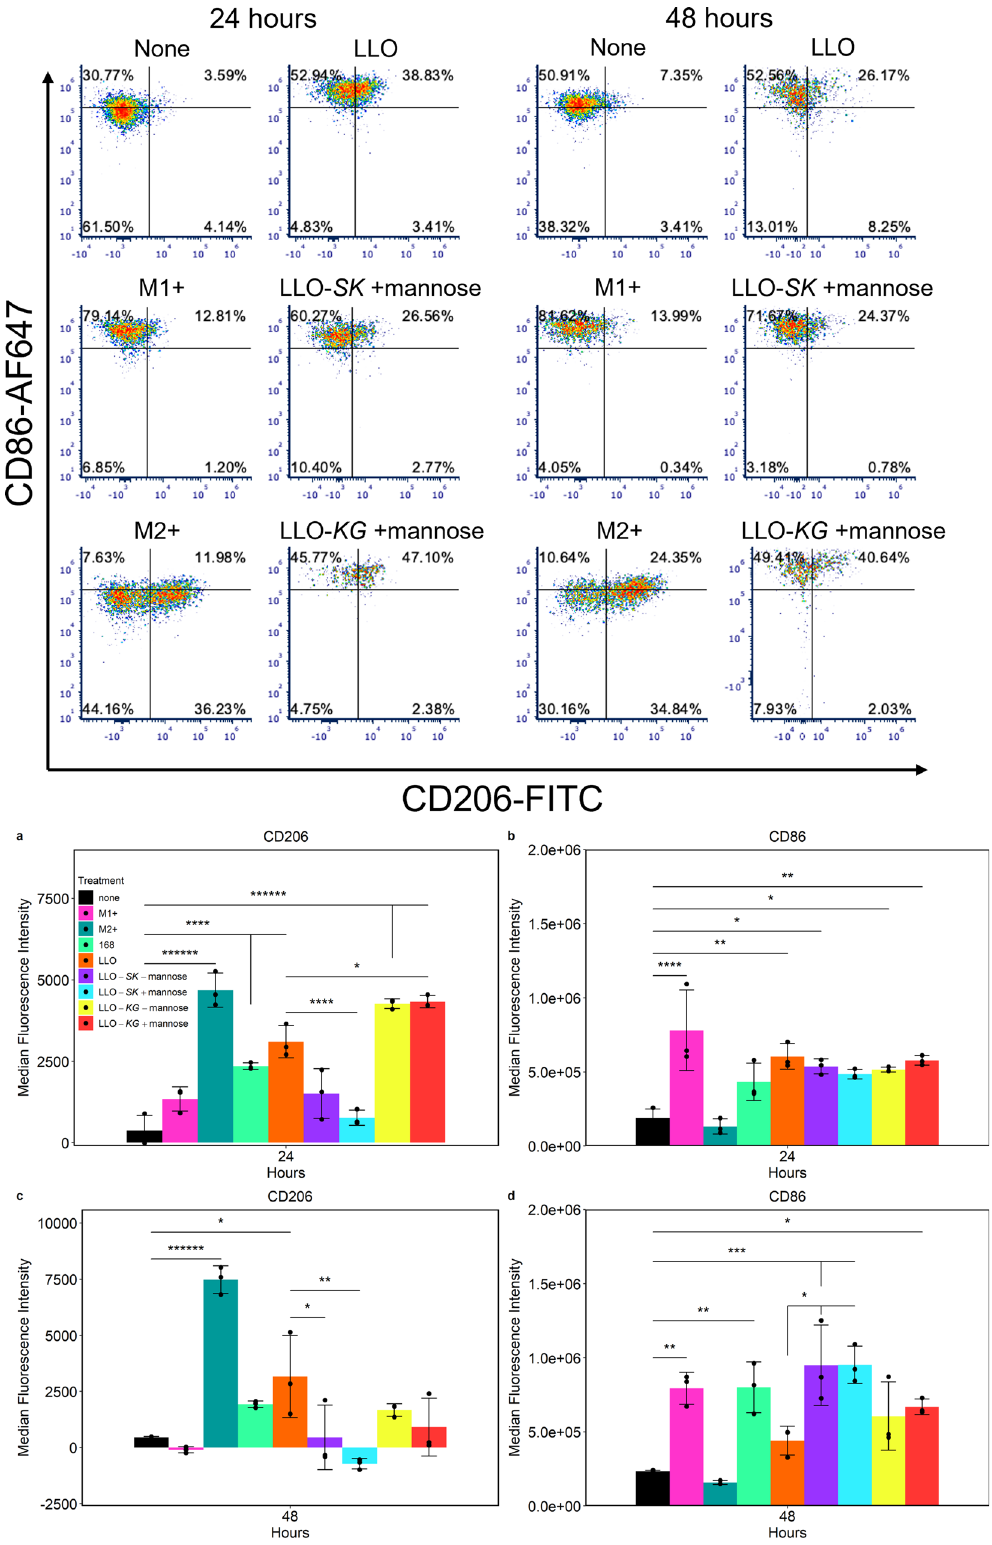
Fig. 5 Flow cytometry demonstrated TF strain-mediated shifts of J774A.1 cell marker expression. Flowcytometricanalysis revealedchanges in CD86and CD206 induced by expression of transcription factors from the EES (top panel). These data are representative examples, taken as the median value of n = 3. Average CD86 or CD206 median fl uorescence intensity (MFI) is compared among all treatments at each time point (lower panel, n = 3); ( a ) CD206 at 24h, ( b ) CD86 at 24h, ( a ) CD206 at 48h, ( b ) CD86 at 48 h. J774A.1 cells were untreated (none), treated with LPS and IFN- γ (M1 + ), IL-4 and IL-13 (M2 + ), B. subtilis strain 168 (168), LLO strain (LLO), LLO- SK with and without mannose (LLO- SK -mannose, LLO- SK + mannose) and LLO- KG with and without mannose (LLO- KG -mannose, LLO- KG + mannose) at 24 and 48 h post initial treatment. Plotted data is mean±SD; * p < 0.05, ** p <0.01, *** p < 0.001, ***** p < 0.00001.